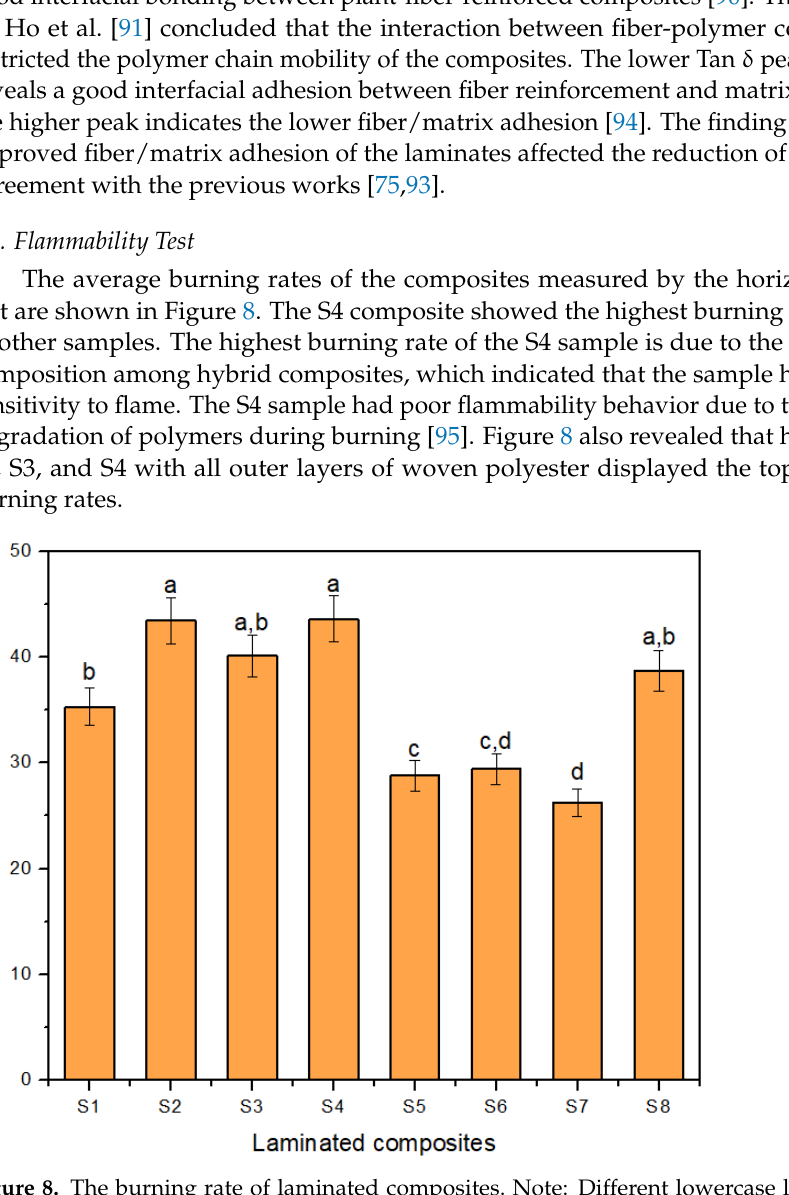
Figure 8. The burning rate of laminated composites. Note: Different lowercase letters indicate a significant difference.